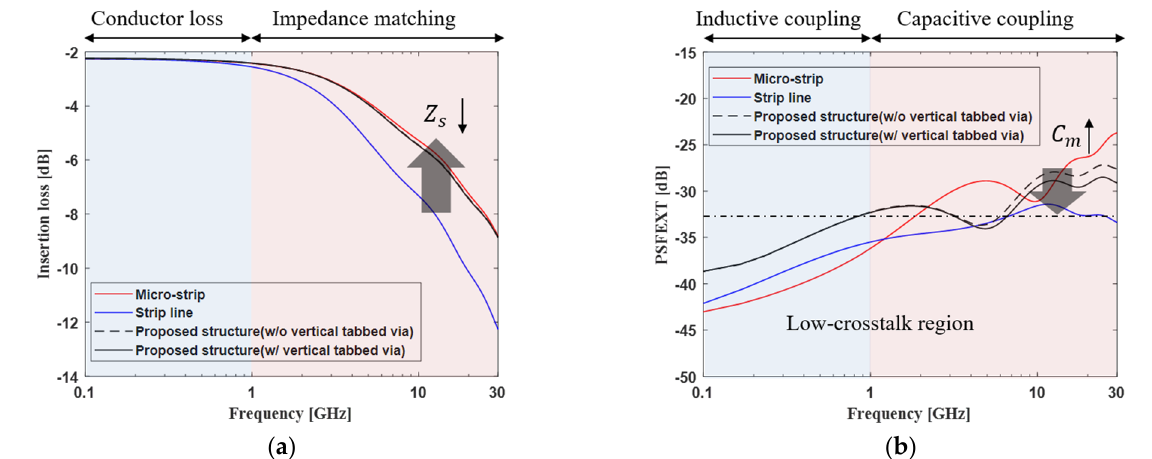
Figure 12. Frequency domain analysis of the proposed channel structure and conventional channel structure: ( a ) insertion loss and ( b ) PSFEXT.